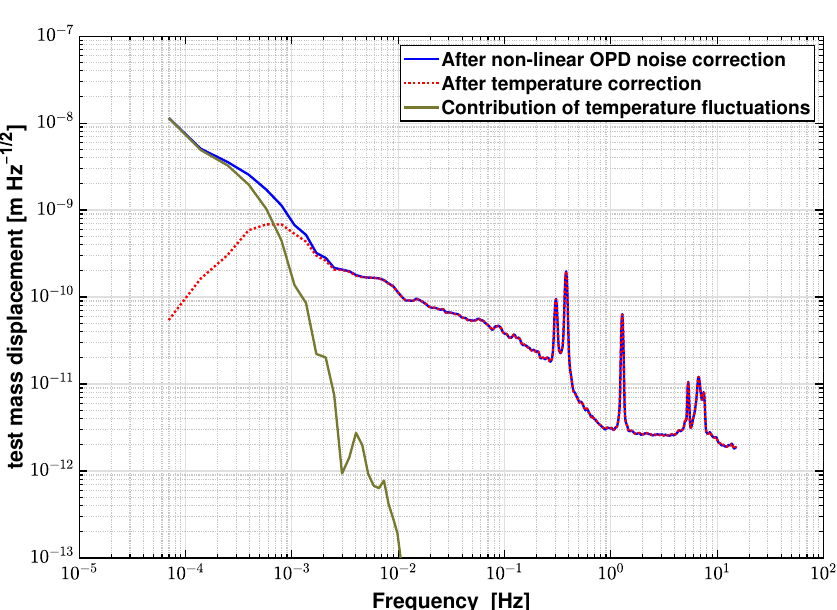
Figure 12. Contributions of temperature fluctuations estimated by a spectral analysis method, and the measurement results before and after correction of this noise source. The noise floor is reduced from √ √ 6.5 × 10 − 9 m/ Hz to 9.8 × 10 − 11 m/ Hz at 0.1 mHz after applying the noise correction